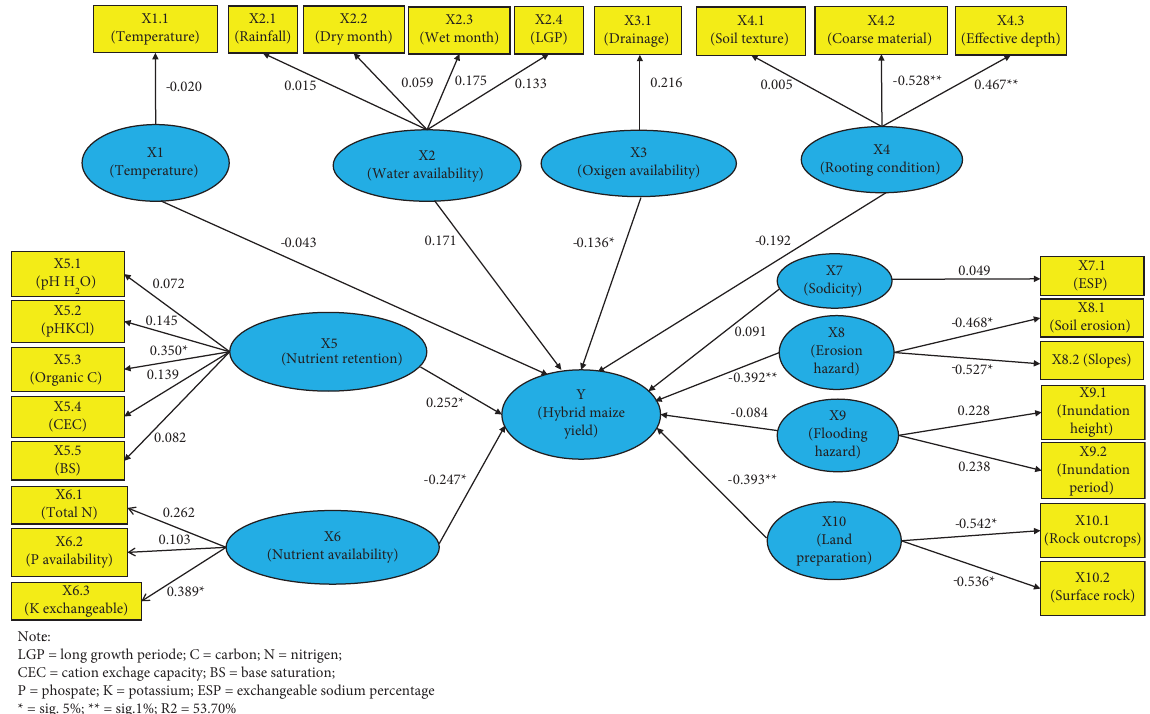
Figure 3: Path coefcient of land quality on hybrid maize